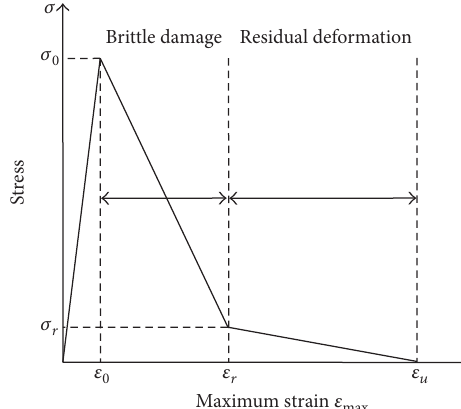
Figure 1: Damage evolution relationship between damage variable 𝑑 and maximum strain 𝜀 max